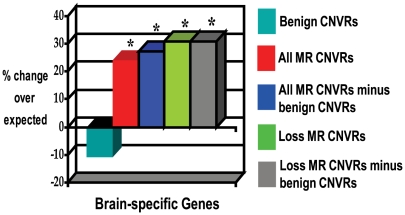
Enrichment of genes, overlapped by MR–associated CNVRs, that are expressed highly in the brain relative to other-tissue (brain-specific genes).Such genes are defined as those whose level of expression in the brain exceeds 4 times the median expression level in all other tissues (see Materials and Methods). MR–associated CNVR sets denoted “minus benign CNVs” have had genes removed that are also overlapped by benign CNVRs showing the same direction of copy number change (i.e. Gain or Loss) as its overlapping MR–associated CNVR. Columns marked with an asterisk (“*”) are significantly enriched (FDR<5%).